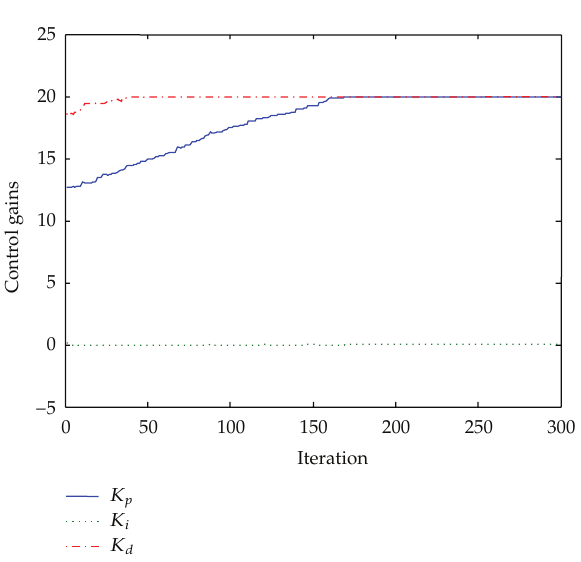
Figure 3: Iteration response of K p ,K i ,K d